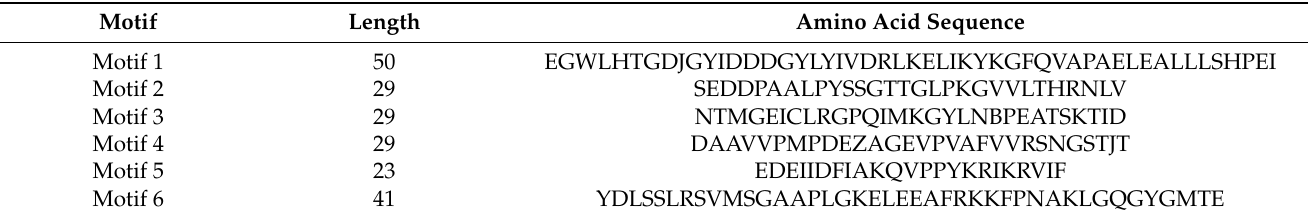
Table 2. The conserved motifs in the St4CL protein sequences.